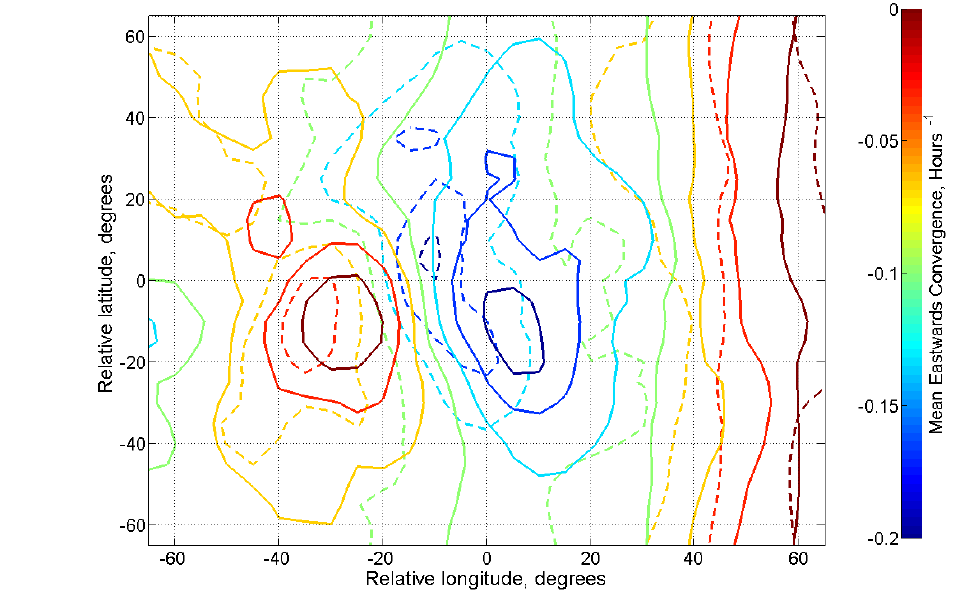
Figure 2. Mean zonal TEC convergence relative to the centre of clusters of S4 events. Solid lines represent the convergence field at time of maximum S4 and dotted lines 20 minutes